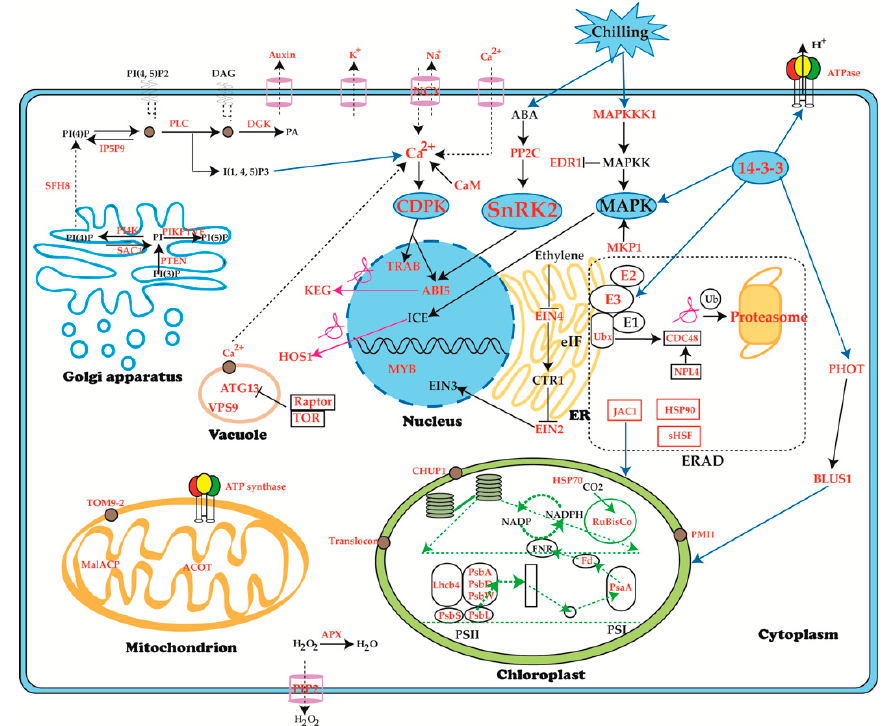
Figure 8. Schematic presentation of systematic chilling response and defense mechanisms in J. curcas seedling at phosphorylation level. The phosphorylation regulatory sites were shown in Table 1. Black solid lines with arrows represent catalytic reaction, while dotted lines with arrows represent material transport. Blue solid lines with arrows represent direct relationship, while magenta lines with arrows represent ubiquination. Black solid lines with stubs represent negative regulation. Green dotted lines with arrows in chloroplast represent transport between PSII and PSI. The proteins labeled with red colors represent significantly changed phosphoproteins among C0 h, C6 h, C24 h and R24 h. The area outlined with dotted square represents ER associated degradation (ERAD).